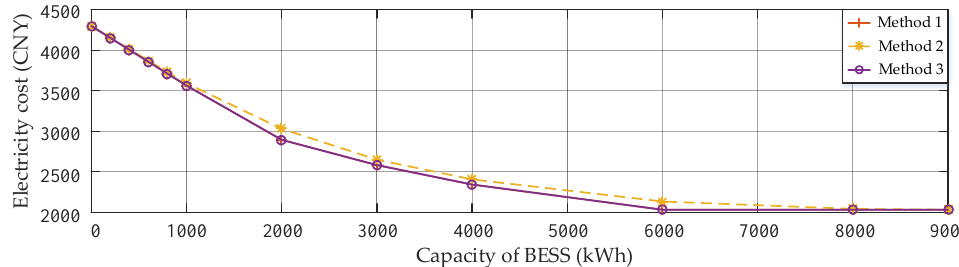
Figure 7. Effectiveness of charging electricity cost reduction of three scenarios with BESS.